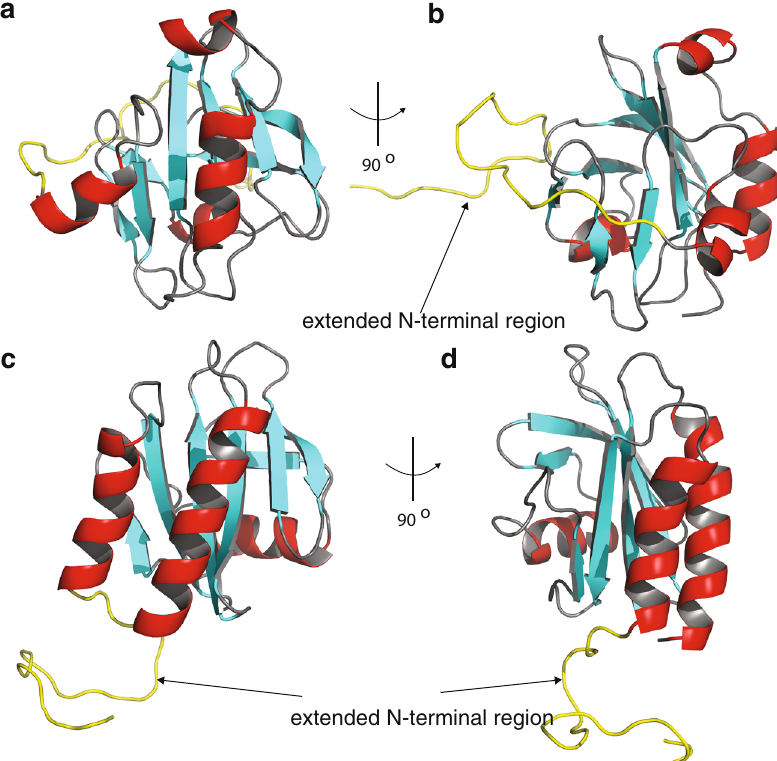
Fig. 5 The N-terminal extension is also present in other Asgard archaea. Structural representation of heimPro fi lin a – b , and models of Thor_TFG12995.1- thorPro fi lin c – d , showing the N-terminal extensions. The Thorarchaeota pro fi lin was modeled in RaptorX online software while the heimPro fi lin 3D structure was determined by NMR spectroscopy in this